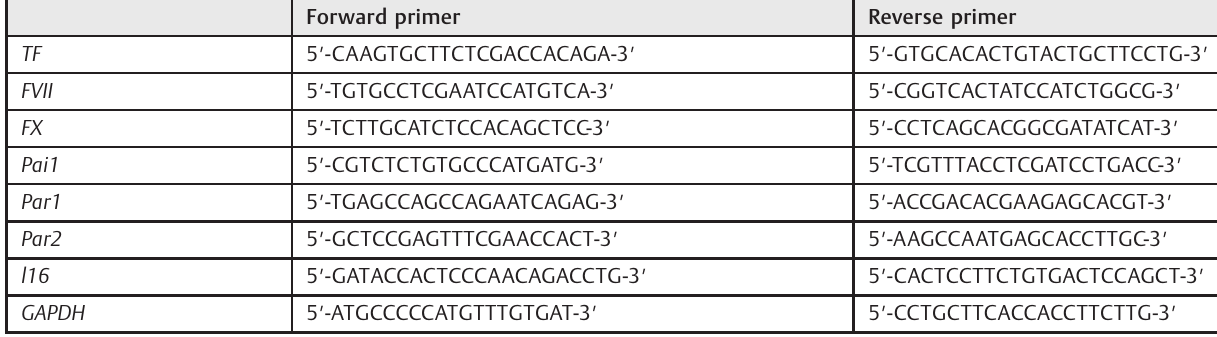
Table 1 Primers used for the semi-quanti fi cation of mRNA levels of coagulation and in fl ammatory factors in cultured Colon26 cells Forward